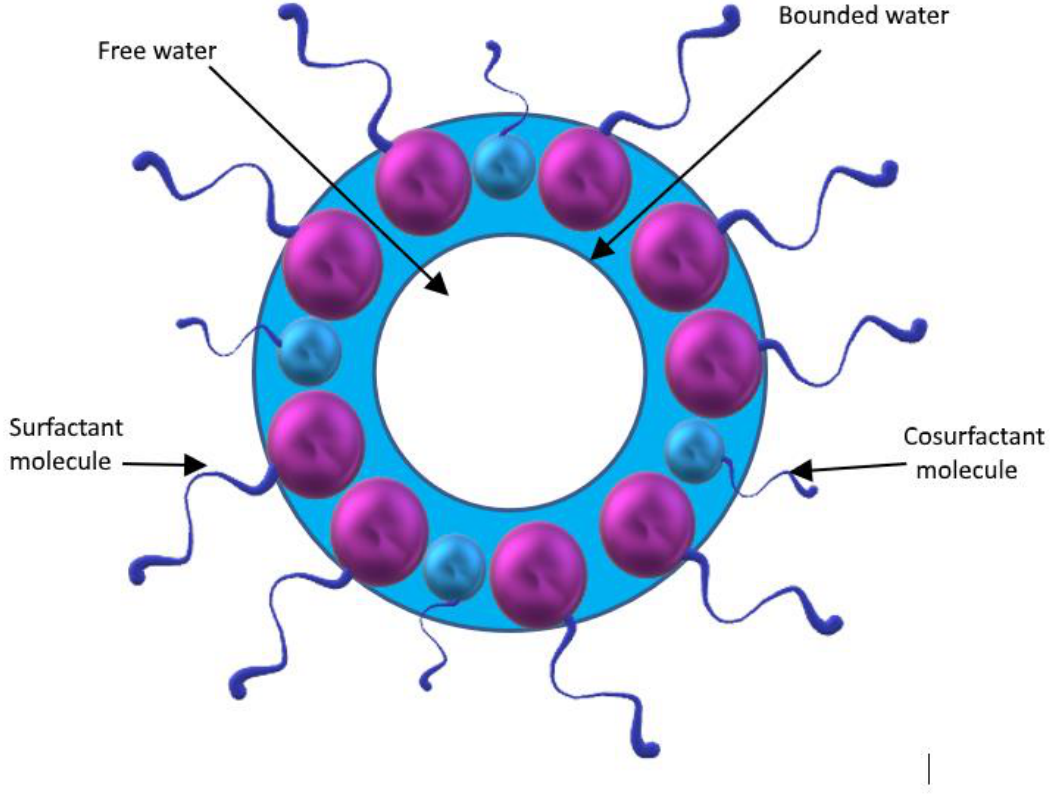
/ O micro- / nano-emulsion Figure 7. Schematic of W/O micro-/nano-emulsion droplet. Figure 7. Schematic of W